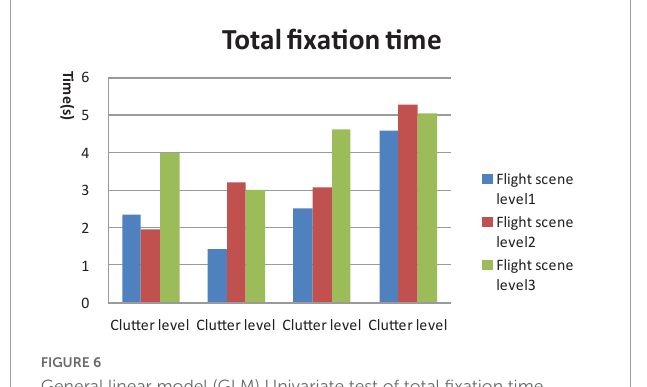
FIGURE6 General linear model (GLM) Univariate test of total fixation time.